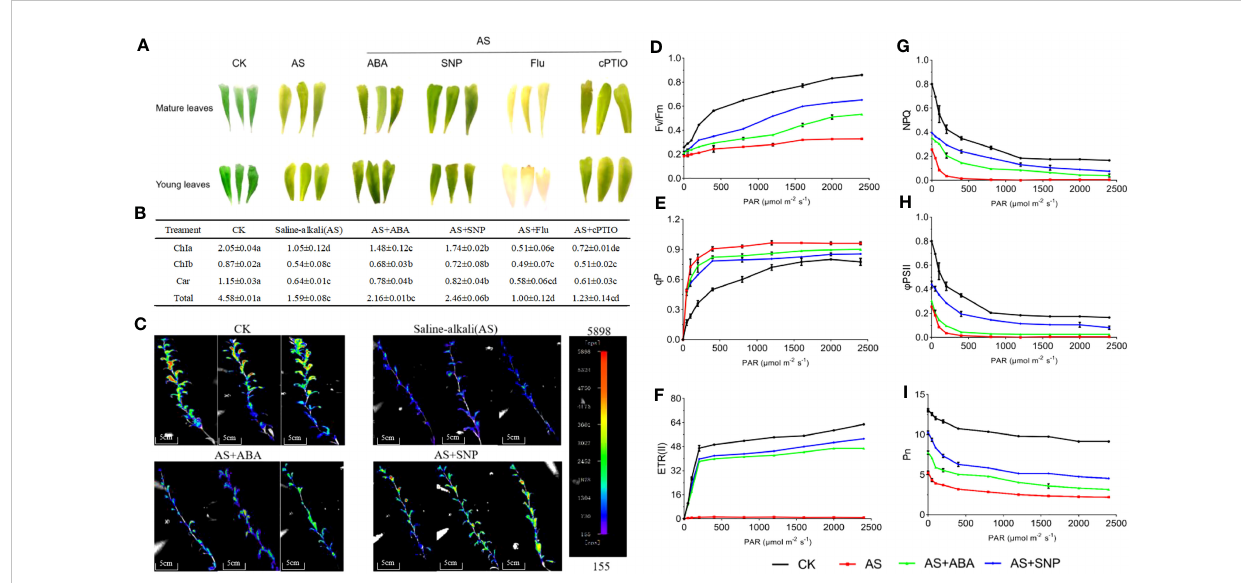
FIGURE 5 Effects of different treatments on chlorophyll content and photosynthesis in leaves of N. tangutorum seedlings. 40-day-old seedlings were treated with different treatments (100 mM alkali, 100 mM alkali +15 m m ABA/5 m m Flu, 100 mM alkali +50 m m SNP/70 m m cPTIO) for 12 days (AS : NaHCO 3 : Na 2 CO 3 = 9:1, pH=9.5), and subsequent experiments are the same. Plants grew in Hoagland solution served as controls(CK). (A) : Phenotypes of old and new leaves under different stress treatments; (B) : determination of chlorophyll content; (C) : Fluorescence imaging of plant chlorophyll in vivo ; (D – I) : Determination of photosynthetic indexes under different treatments, including: Photochemical ef fi ciency of photosystem II (Fv/Fm); photochemical quenching (qP); photosystem II apparent photosynthetic electron transfer ef fi ciency (ETRII); non photochemical quenching